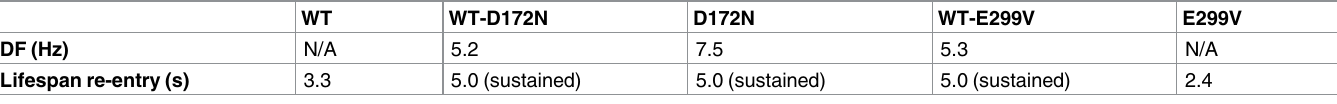
Table 2. A summary of dominant frequency and lifespan in 3D